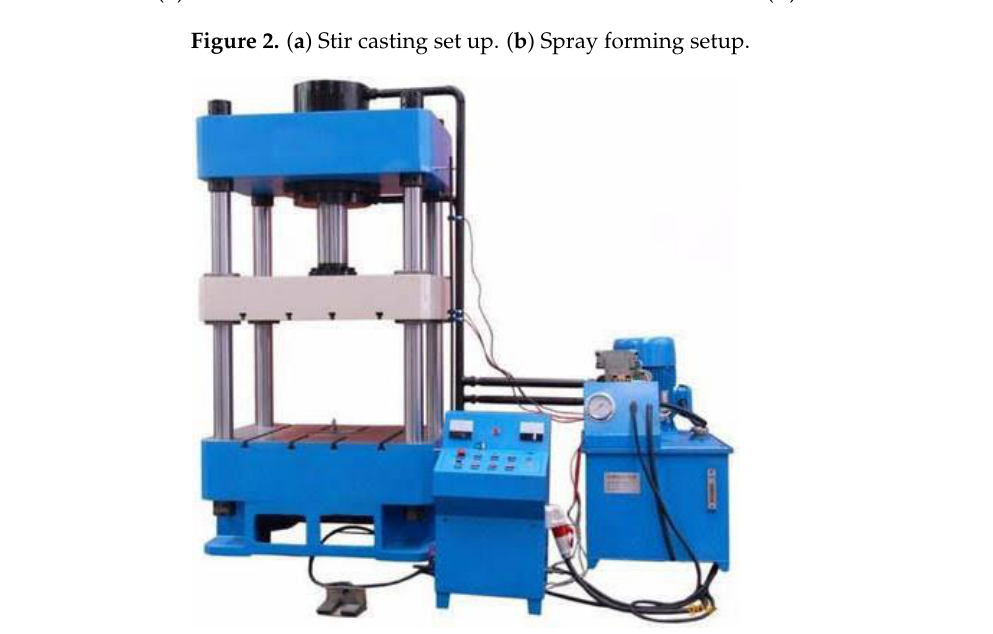
Figure 3. Hydraulic hot press machine.